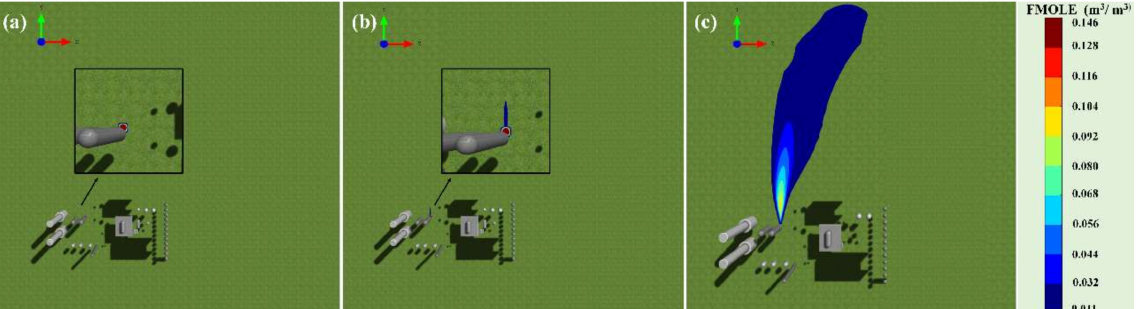
Figure 4. Cloud map of combustible gas volume fraction under different leak apertures. ( a ) Cloud map of 5 mm leak aperture. ( b ) Cloud map of 25 mm leak aperture. ( c ) Cloud map of 100 mm leak